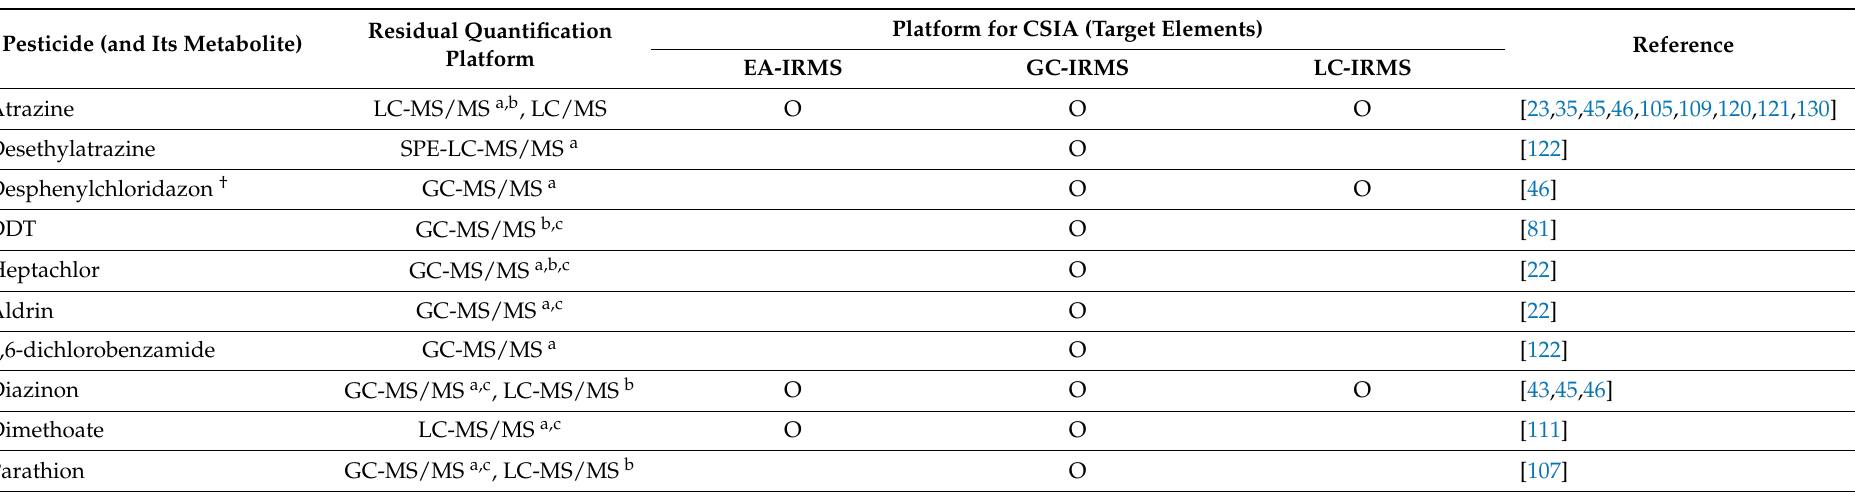
Table 4. Representative examples of general methods for residues and measurement systems for analyzing isotopes of pesticides in agricultural products and environmental samples. Pesticide (and Its